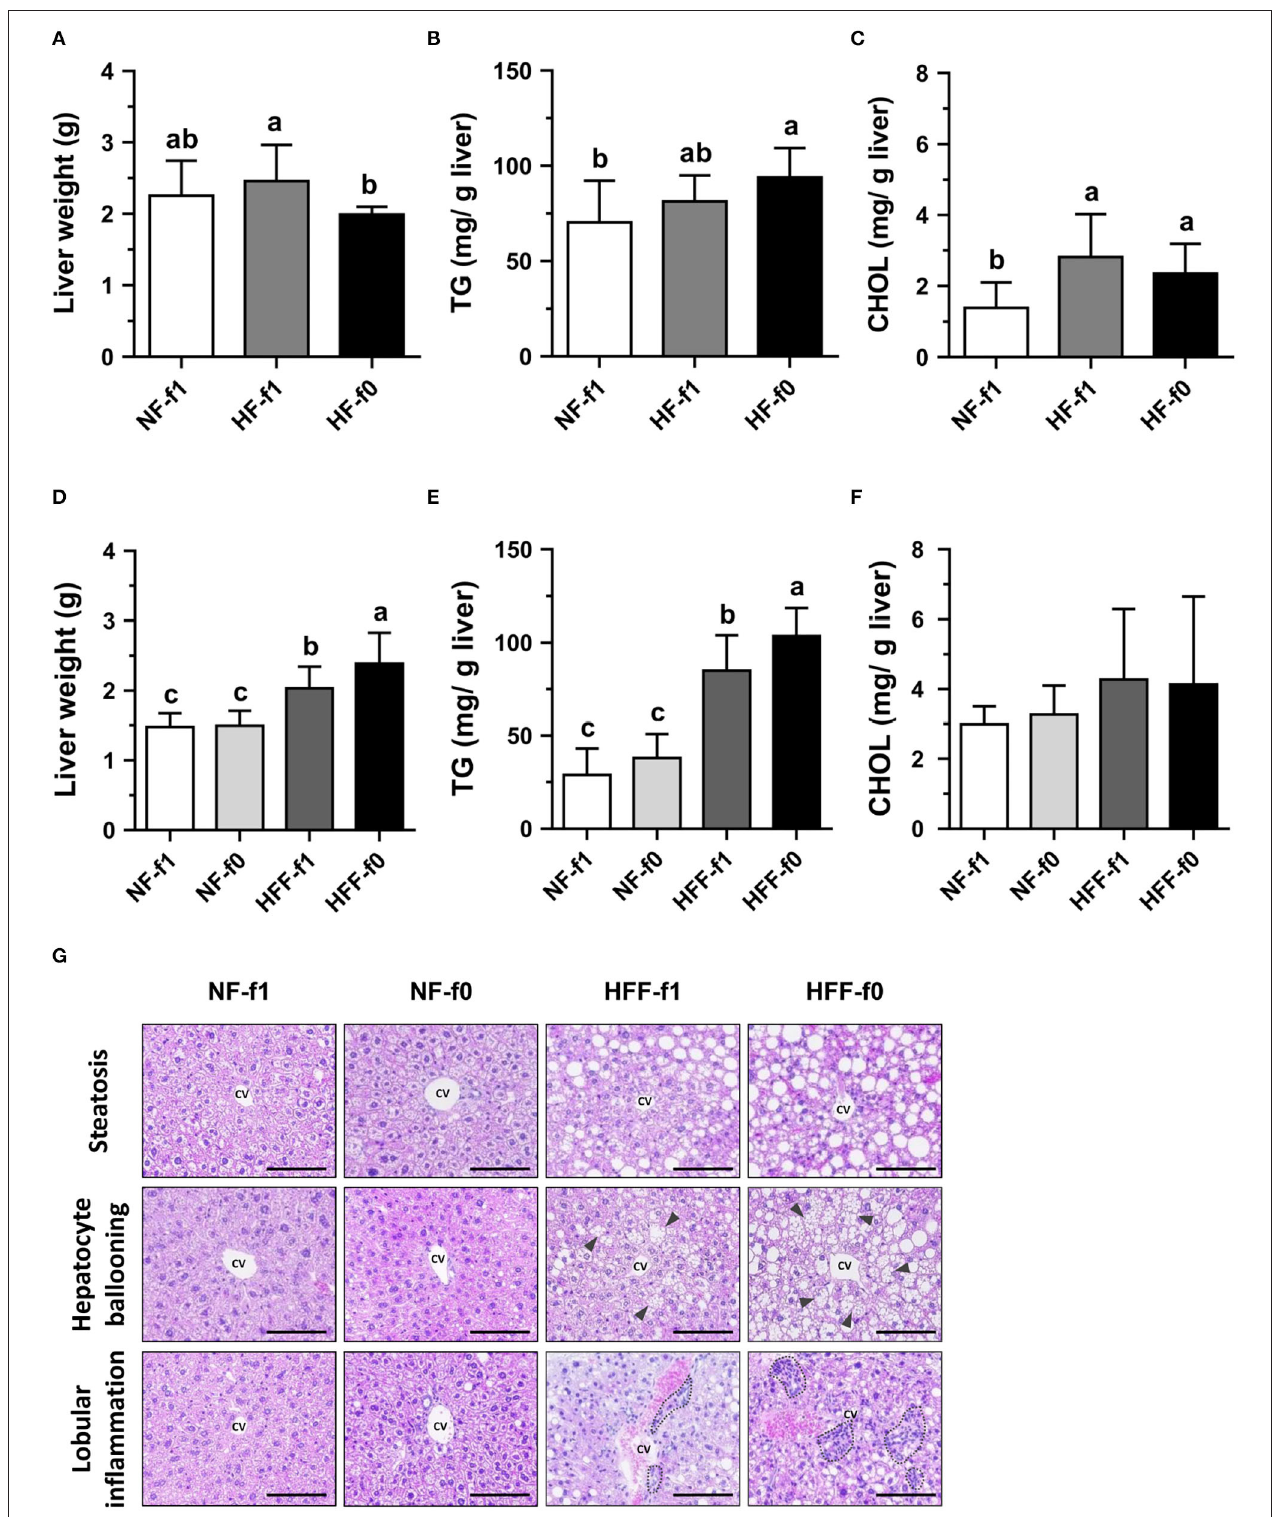
FIGURE 6 | Folate deficiency increased hepatic lipid accumulation of mice fed either high-fat (HF) or high-fat high-fructose (HFF) diet for 12 months. Liver (A) weight, (B) TG content, and (C) cholesterol (CHOL) content from NF or HF diet-fed mice, and (D–F) from NF or HFF diet-fed mice, respectively. (G) The representative images of H&E-stained liver (scale bar: 100 µ m) from HFF diet-fed mice, the triangle indicates hepatocellular ballooning, and the dotted area indicates infiltration of mononuclear leukocytes. Data are mean ± SD ( n = 10–16 per group). Bars with different letters indicate the significant difference ( p < 0.05) analyzed using one-way ANOVA and Duncan’s post-hoc test. CV, central